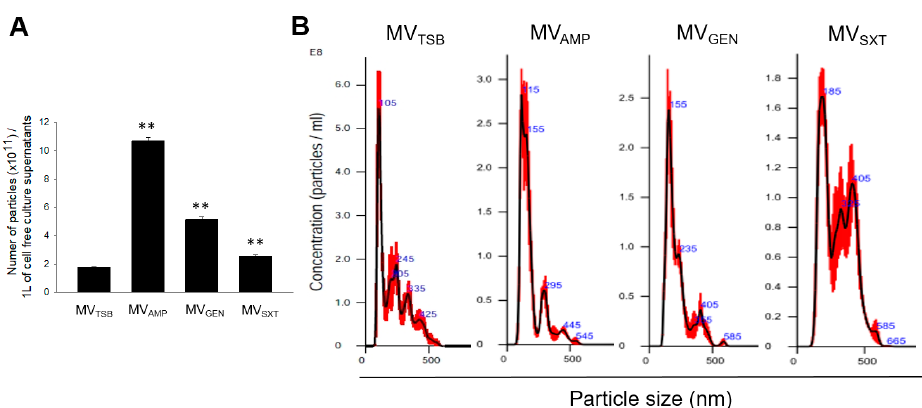
Figure 2. Production of membrane vesicles (MVs) in L. monocytogenes cultured under antibiotic stress conditions. Bacteria were grown to late exponential phase (OD 600 of 1.4). MVs were then isolated from bacterial culture supernatants. Nano particle tracking analysis (NTA) was performed to determine the number and size of MVs. ( A ) Particle numbers of MV TSB , MV AMP , MV GEN , and MV SXT in 1 L of cell free culture supernatants. Data are presented as mean ± SD of three independent experiments. **, p < 0.01 compared to MV TSB . ( B ) Size distribution of MV TSB , MV AMP , MV GEN , and MV SXT based on NTA. Data are representative of three independent experiments with similar results.